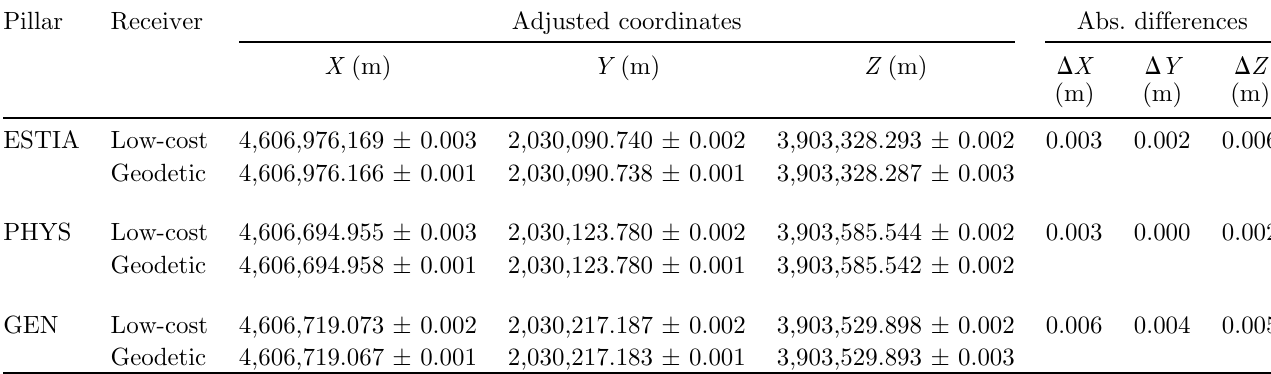
Table 8a. Adjusted network coordinates in WGS84 (minimally constrained solution).